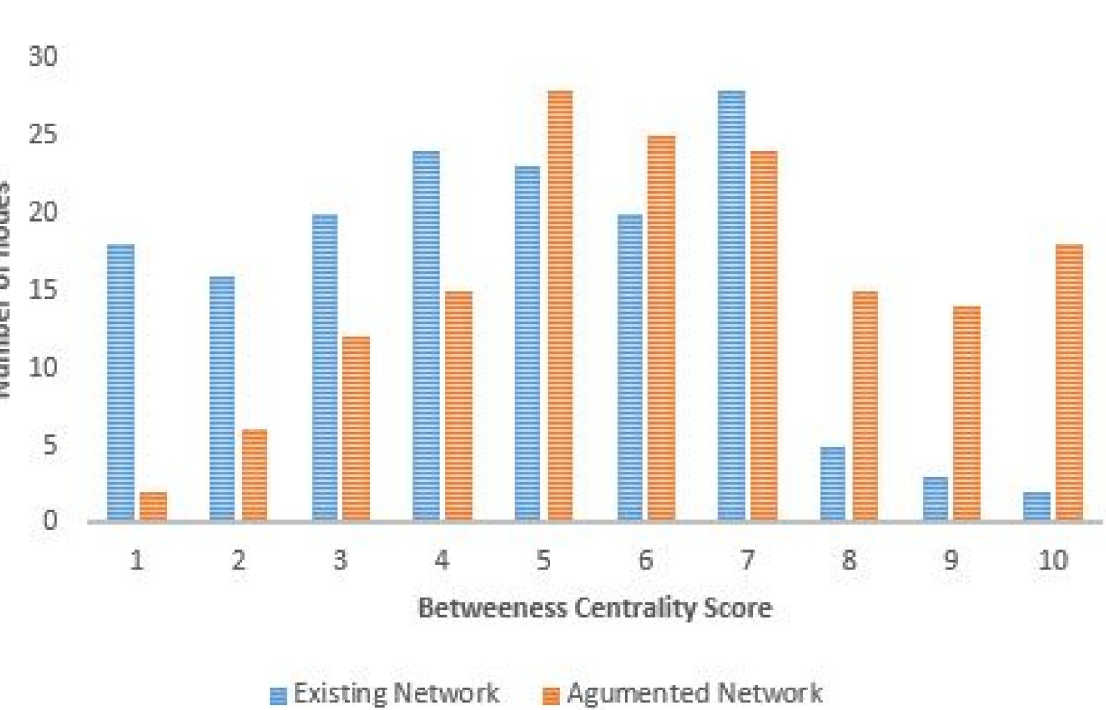
Fig 17. Betweenness centrality score: Existing network vs augmented network.